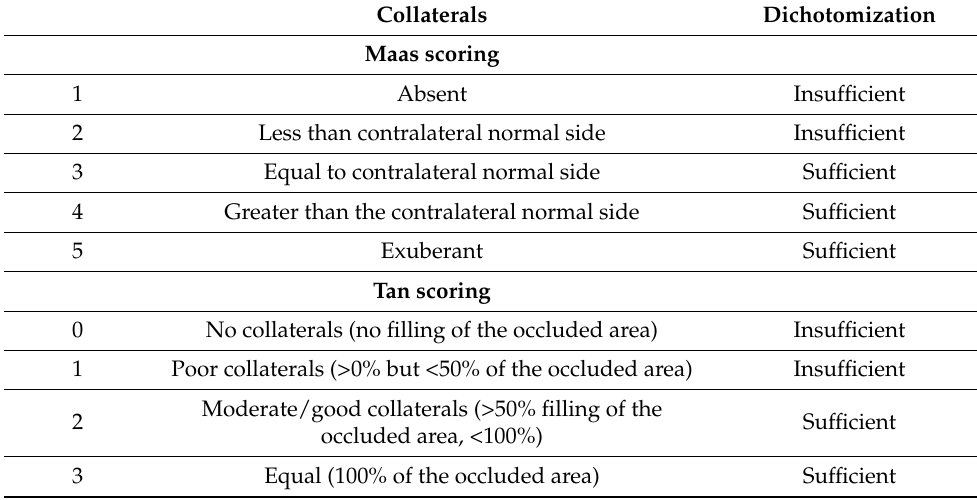
Table 1. Maas and Tan scoring definitions and